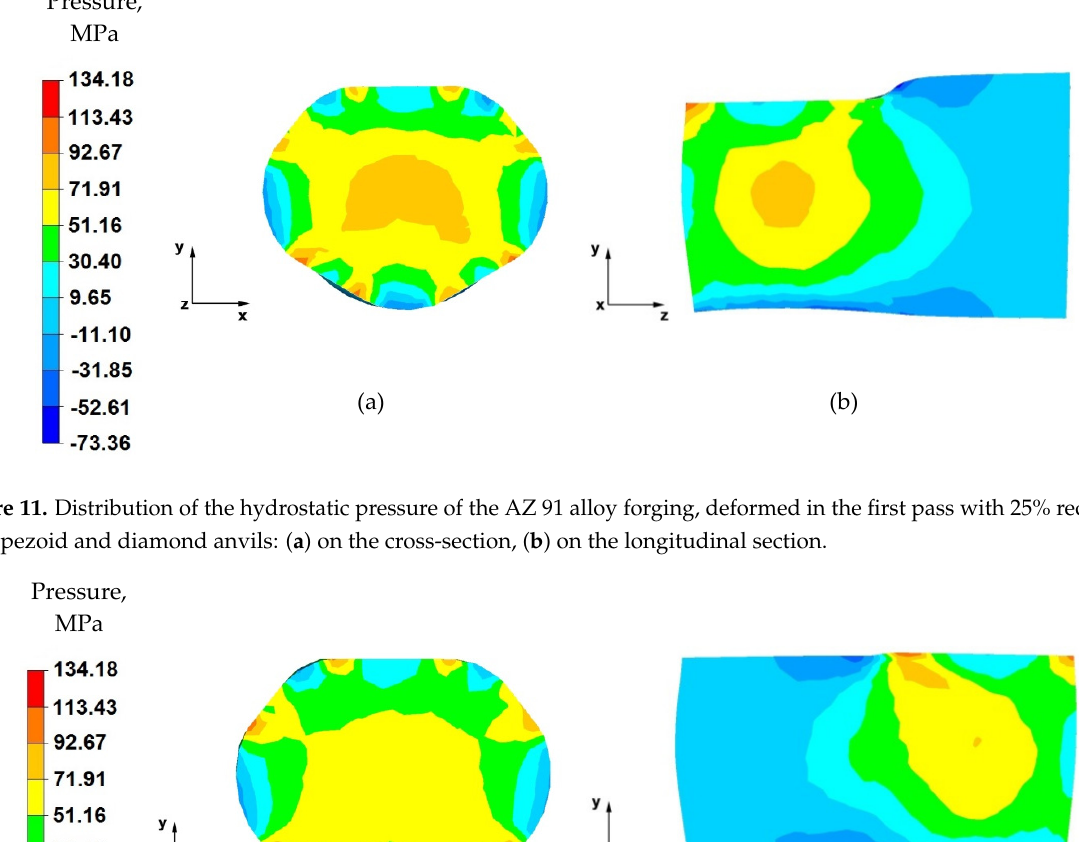
Figure 12. Distribution of the hydrostatic pressure of the AZ 91 alloy forging, deformed in the second pass with 25% reduction in trapezoid and diamond anvils: ( a ) on the cross-section, ( b ) on the longitudinal section. Based on the data in Figure 12a, it can be concluded that the nature of the hydrostatic pressure fields is similar to that obtained in the first forging pass (Figure 8). Similarly to the first forging pass, a good material processing was obtained, from which it can be con- cluded that the finished product will be characterised by good mechanical properties. By analysing the data in Figure 12b, it can be stated that, apart from the zones of contact of the material with the lower diamond anvil, the material flows freely without